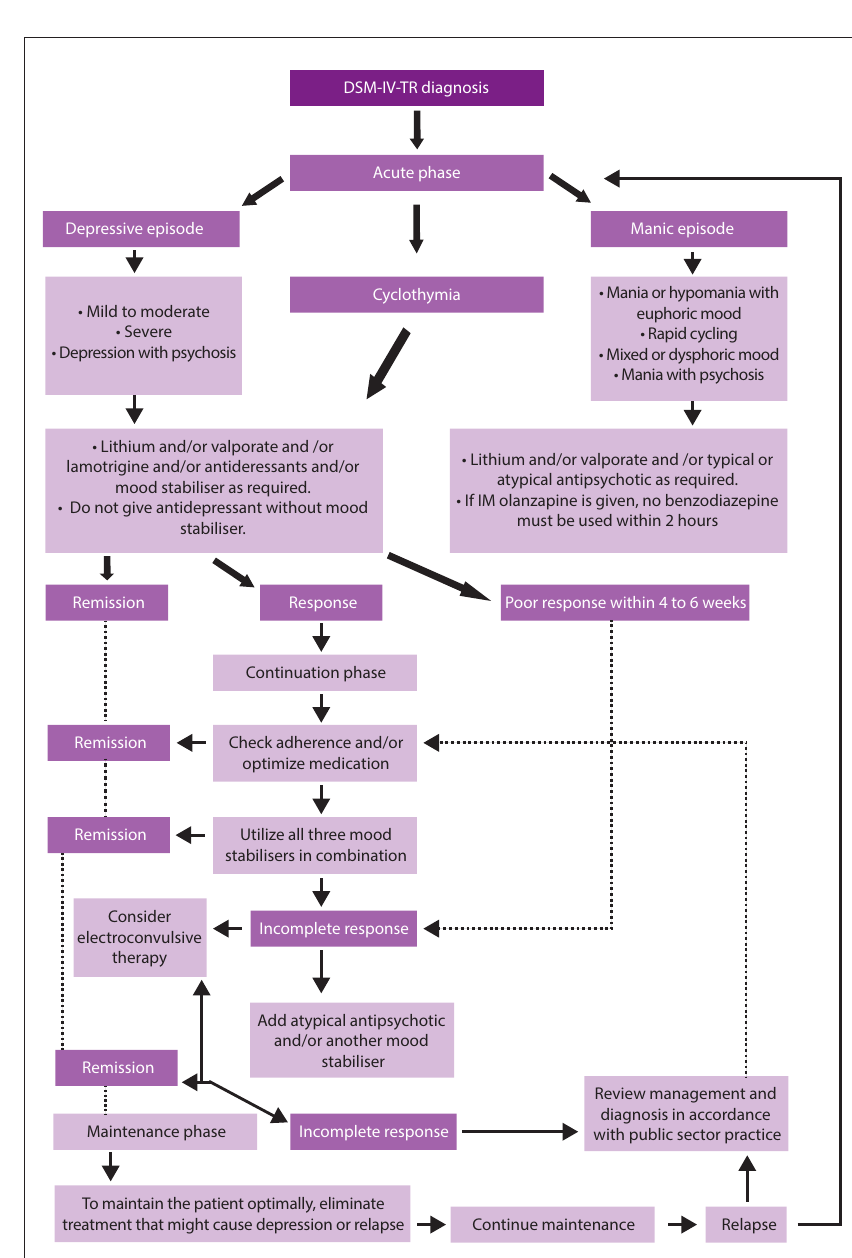
Fig. 2. Bipolar disorder algorithm.